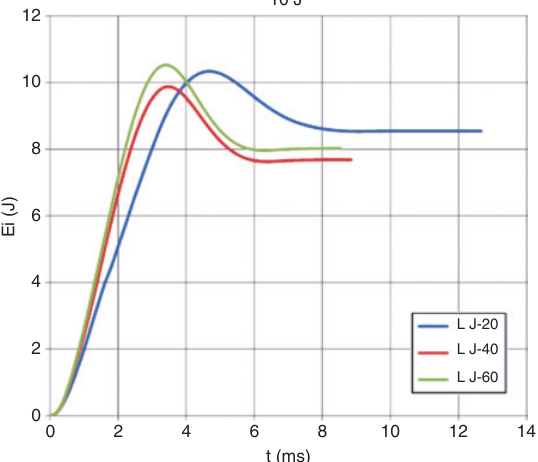
Figure 8 Variation of the impact energy vs. contact time of composite single-lap joints.